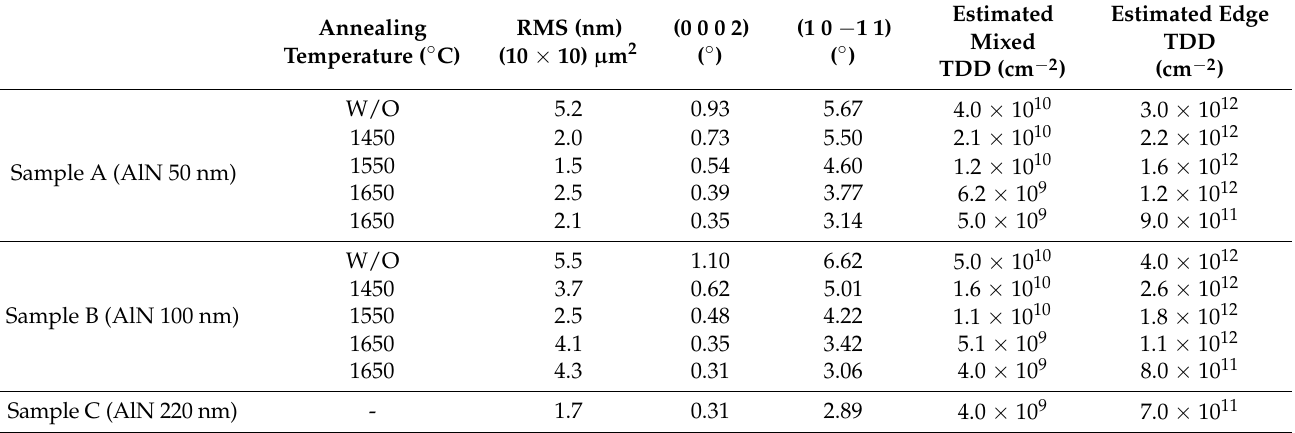
Table 1. Table summarizing the main crystalline and morphological properties of samples A, B, and C measured by atomic force microscopy and X-ray diffraction before and after FFA and after an AlN regrowth